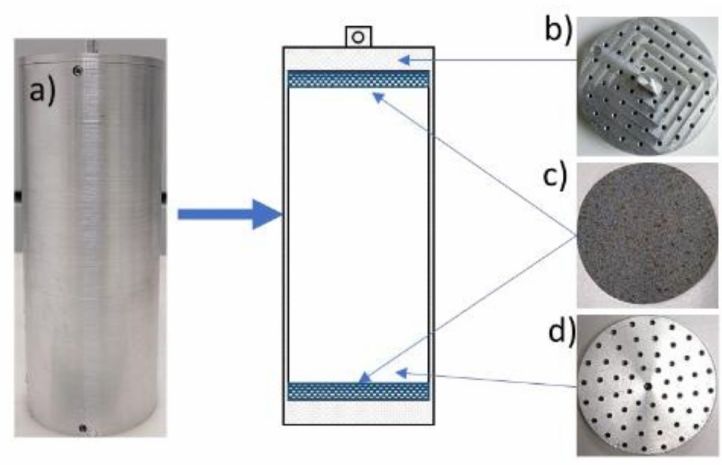
Figure 4. Photos and description of the interior of the aluminum cell: ( a ) aluminum body, ( c ) porous bauxite stones, ( b , d ) perforated aluminum